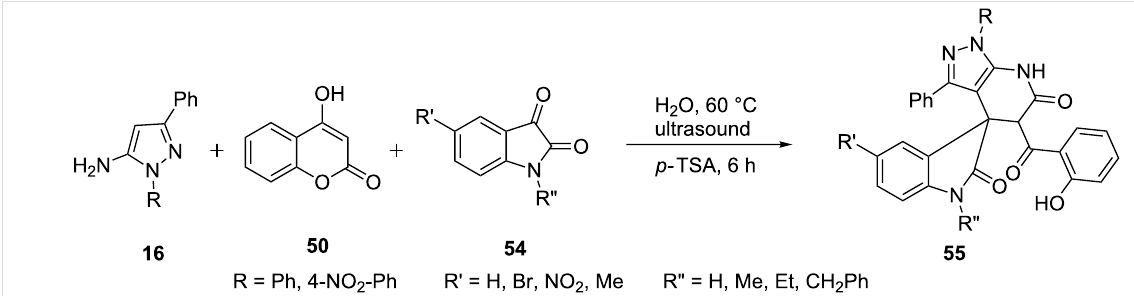
Scheme 11: Ultrasonicated synthesis of spiro[indoline-3,4'-pyrazolo[3,4- b ]pyridine]-2,6'(1' H )-diones.